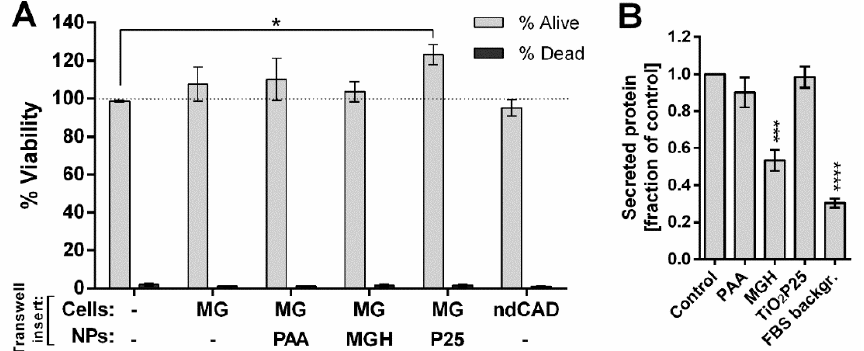
Figure 5. The indirect effects of NPs on mouse neural CAD cells. ( A ) Differentiated CAD cells were incubated with NP exposed microglial cells (MG) for 24 h by using the transwell system. Following incubation with 25 µg/mL NPs, transwell inserts were removed and CAD cells were left to rest for another 24 h in the same conditioned medium before cell viability was assessed microscopically. ( B ) Quantification of proteins secreted by mouse microglial cells incubated with 25 µg/mL NPs for 24 h in FBS free medium. Mean and standard error are shown for three independent experiments. Statistical significance is displayed as follows: ns ( p > 0.05); * p ≤ 0.05; *** p ≤ 0.001, **** p ≤ 0.0001.